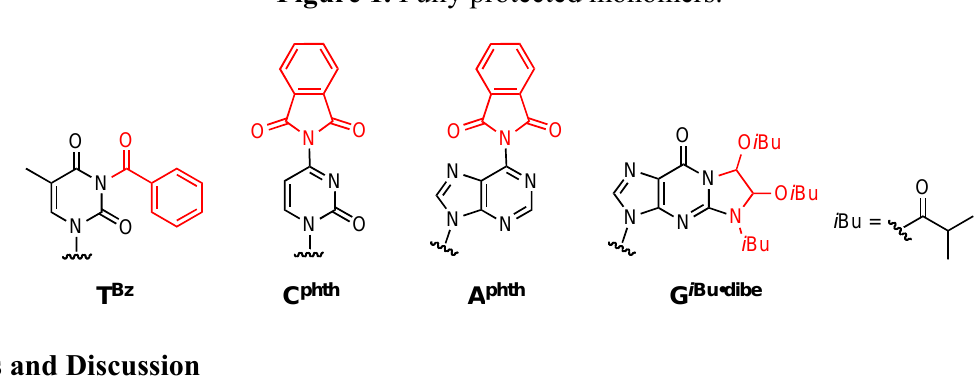
Figure 1. Fully protected